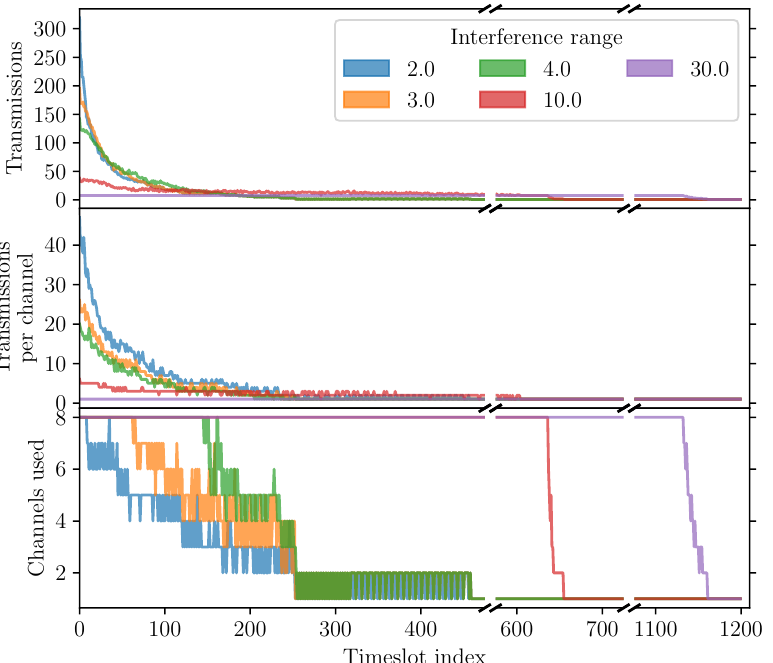
Figure 25. Distribution of concurrent communications over the slotframe for different interference ranges. UWB-TSCH is configured with 8 channels. Note the split